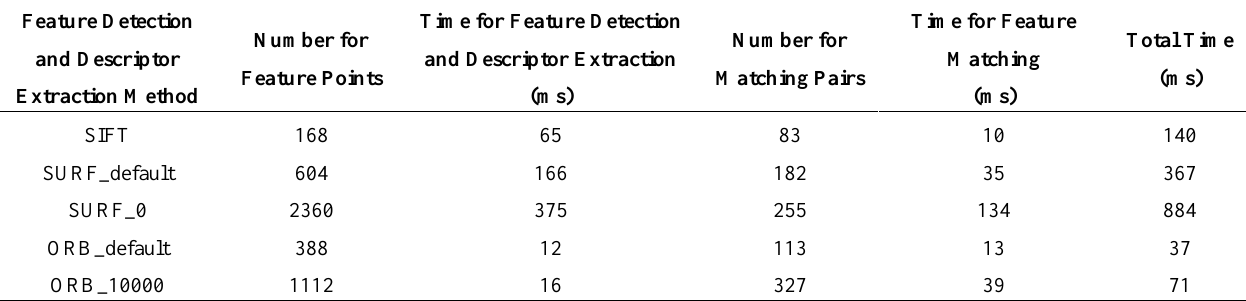
Table 4. Comprehensive Comparison for Feature Detection, Feature Extraction and Feature